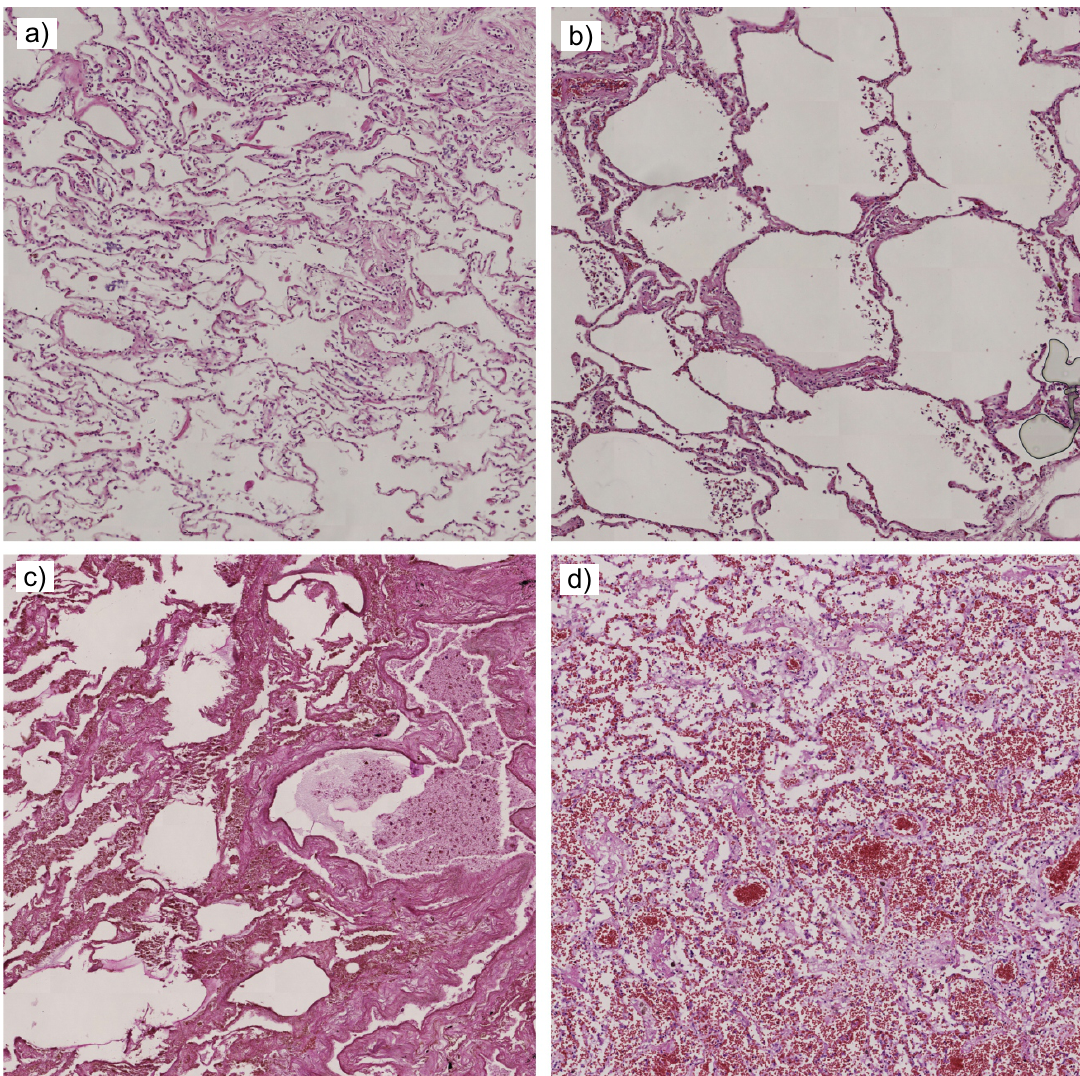
Figure 2. Examples of lung autopsy images (( a ) emphysema, ( b ) edema, ( c ) autolysis, ( d ) blood cells in alveoli and